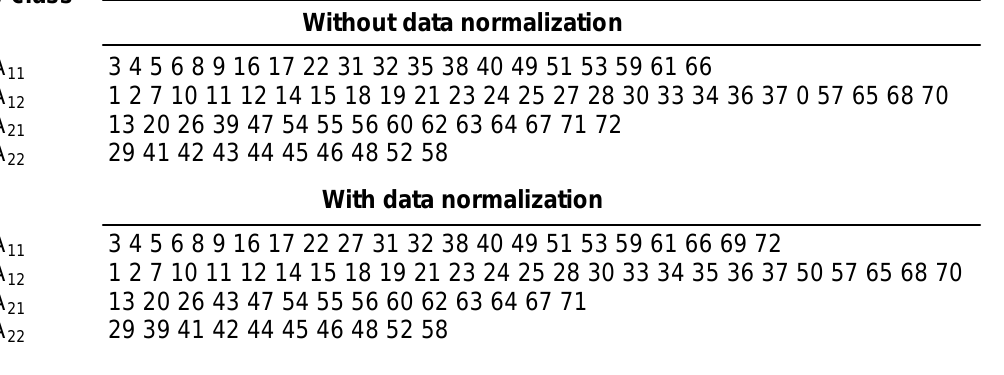
Final Fuzzy Partition of the Cardiac Patients Produced using Seven Characteristics without and with Data Normalization Cardiac Fuzzy class